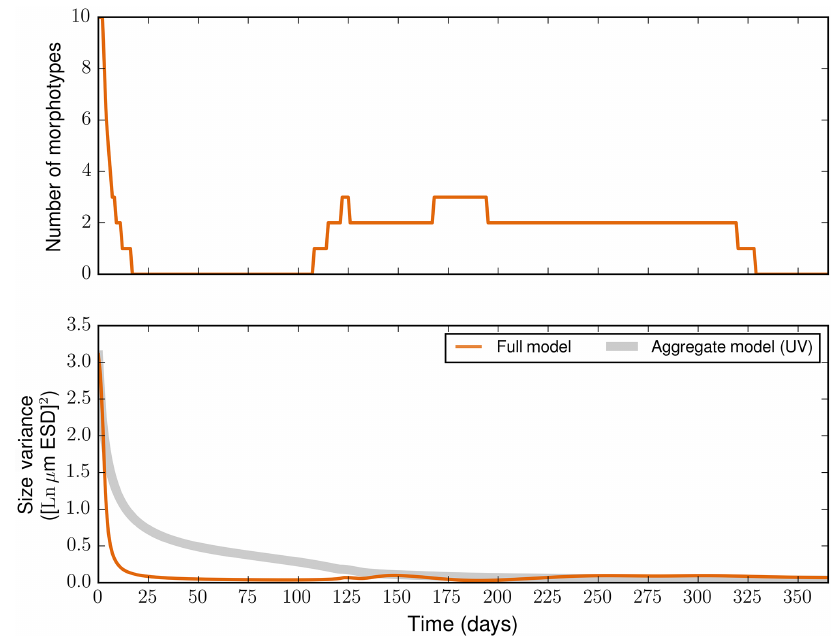
Figure 4. Number of morphotypes and size variance over the first year of the simulation. Here we included the morphotypes with a biomass greater than 0.01mmolNm − 3 . Models that do not consider a mechanism to sustain variance exhibit competitive exclusion of morphotypes and a rapid decline of size diversity.